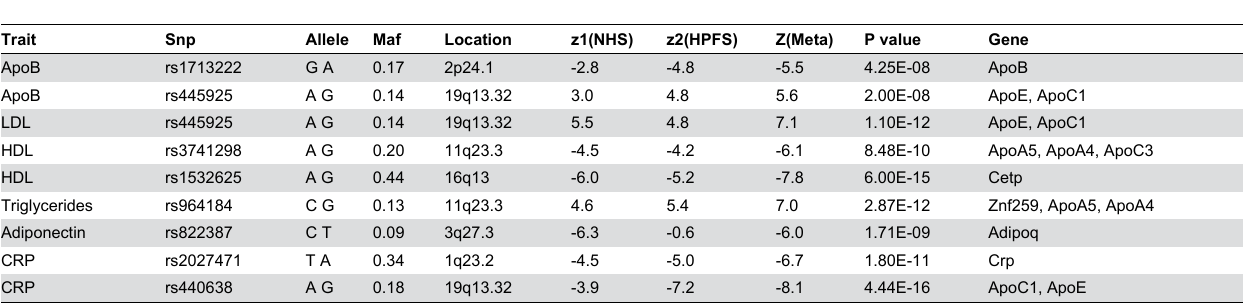
Table 2. SNP associations exceeding thresholds for genome-wide